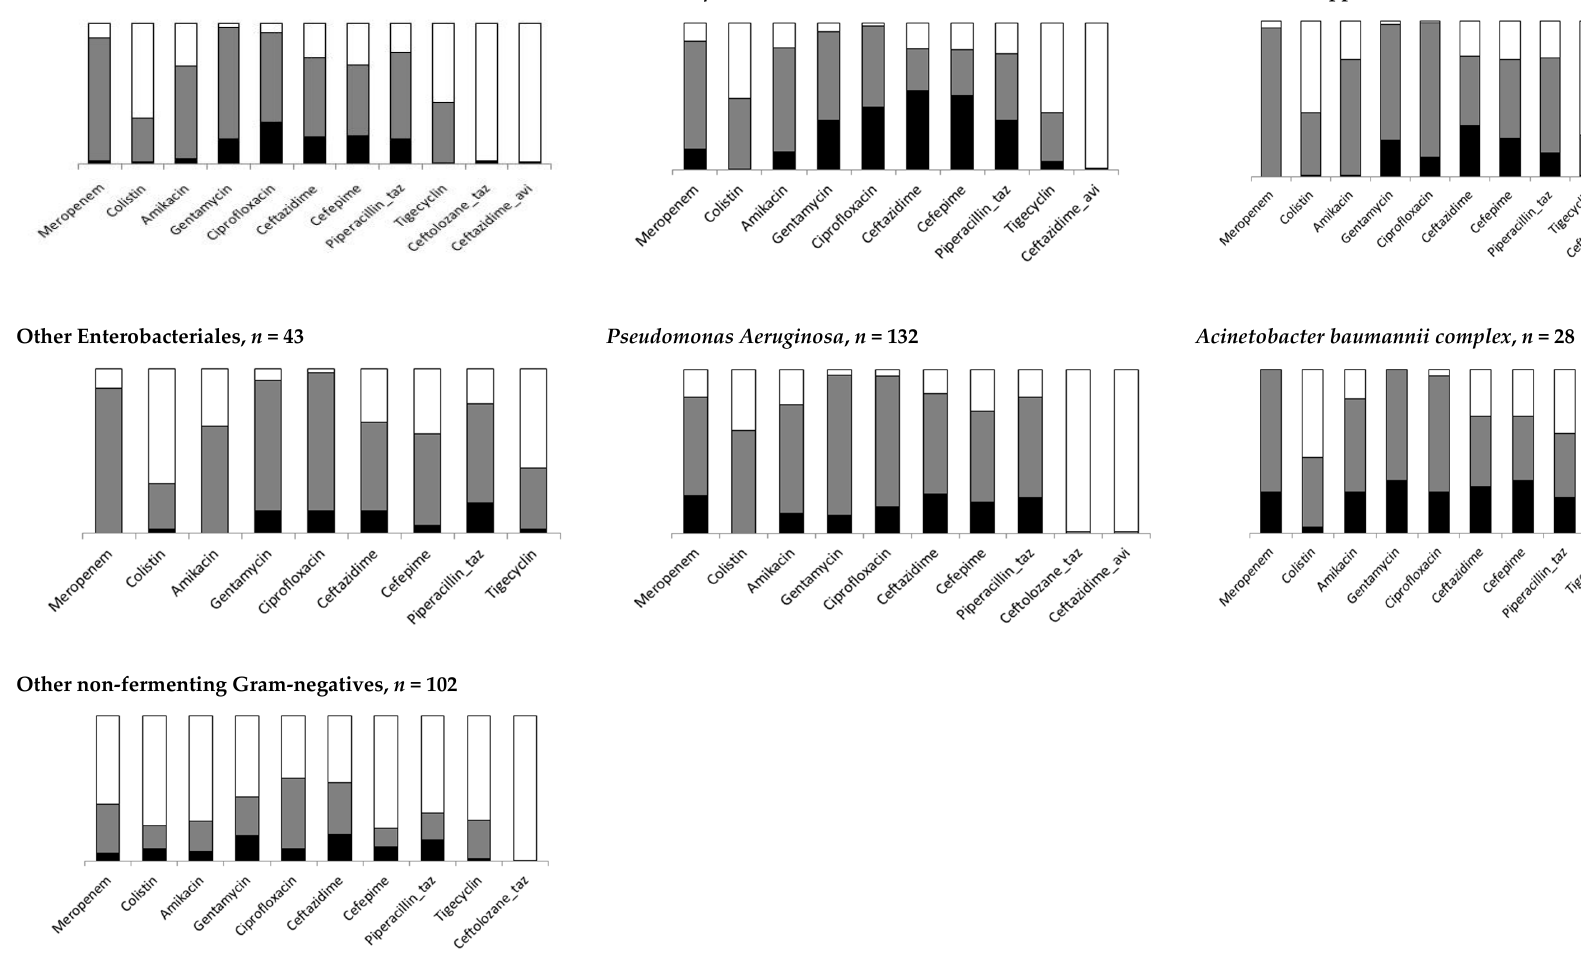
Figure 1. Distribution of resistant antibiotic bacteremia by pathogen type (details in Supplementary Table S3) of Gram-negative isolates. Black box represents percentages of resistant bacteremia, gray box represents susceptible bacteremia, and white box for bacteremia not tested.